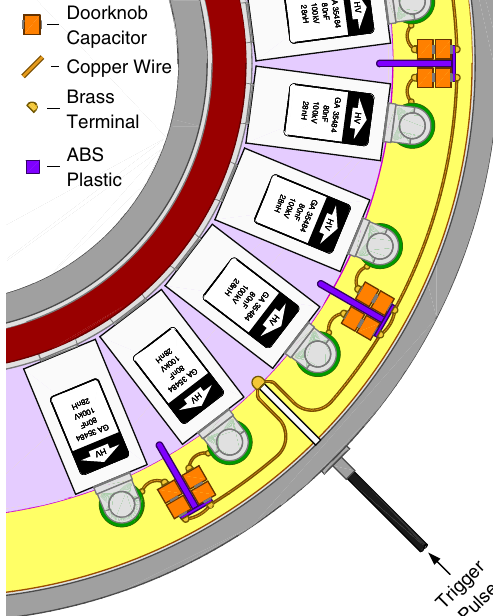
FIG. 5. Top-down view of the 100-GW “ Z-Next ” LTD trigger circuit layout with capacitive coupling (top lid and lid insulator removed). This configuration is mirrored up-down and right-left about the cavity to complete the trigger circuitry to all quadrants of the LTD. Component materials follow the legend given in Fig. 2. Charging circuitry, gas lines, load hardware, fasteners, and seals are omitted from this